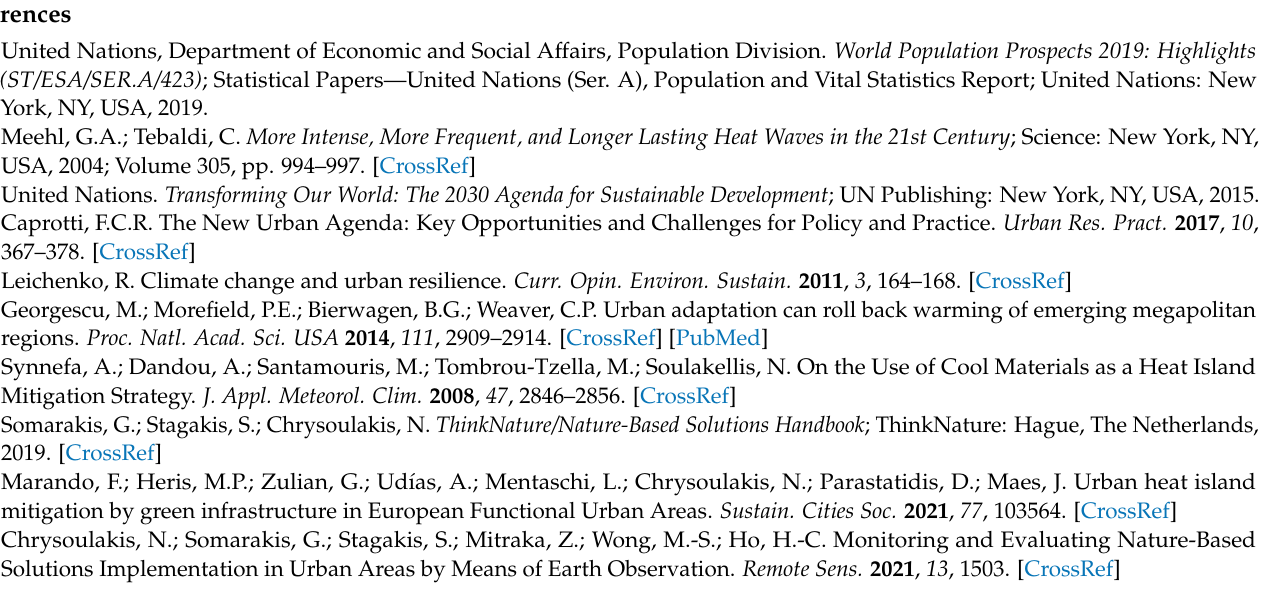
Heraklion (1 × 1 m), Figure S3: Ground Control Points (red circle) and Check Points (orange circle) used for the registration process and validation of the result, Figure S4: Overlay of vegetation layer and nDSM to differentiate between low (<2 m) and high (>2 m) vegetation, Figure S5: Overlay of nDSM and the Buildings layer, Figure S6: Workflow followed to compute errors in flux outputs introduced from the land cover map accuracy, Figure S7: Annual minimum and maximum NDVI values extracted from monthly composites of Sentinel-2 images for 2020, Figure S8: Differences in raw values (columns a and b) and differences in hourly means (column c) of Q*, ∆ Q S , Q E and Q H for the future—baseline model run outputs per grid cell. In column c, daytime and nighttime hours are shown in light grey and dark grey background respectively, Figure S9: Latent Heat Flux (a), Evaporation (b), Total change in soil and surface moisture storage (c) and Soil Moisture Deficit (SMD) (d) model outputs for the baseline and future model run, Table S1: WorldView-2 Sensor wavelengths per band, Table S2: Sentinel-2 bands, Table S3: Confusion matrix for the validation of the 5-class surface cover map shown in Figure 7 (Overall Accuracy: 92.6 %), Table S4: Confusion matrix and class-wise precision of the final surface cover map, Table S5. Current Surface cover percentages and bulk albedo values of grid cells subject to changes in land cover based on the development plan. Imminent changes are shown in the parentheses, Table S6: Morphometric parameters for buildings of grid cells subject to changes in land cover, Table S7: Morphometric parameters for trees of grid cells subject to changes in land cover. Changes based on the development plan are shown in the parentheses, Table S8: Monthly maximum values per grid for the baseline and future development model runs [51,52]. See attached Supplementary Materials